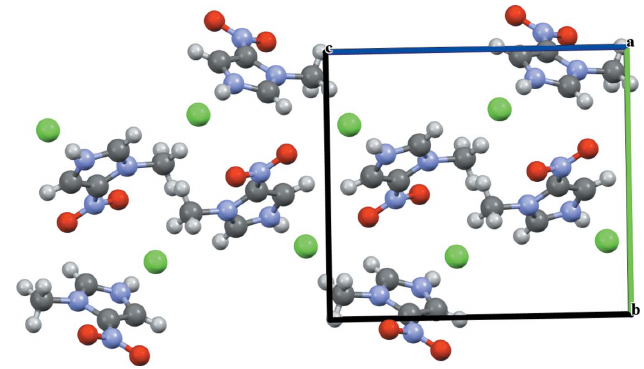
Figure 2 Packing diagram of the title